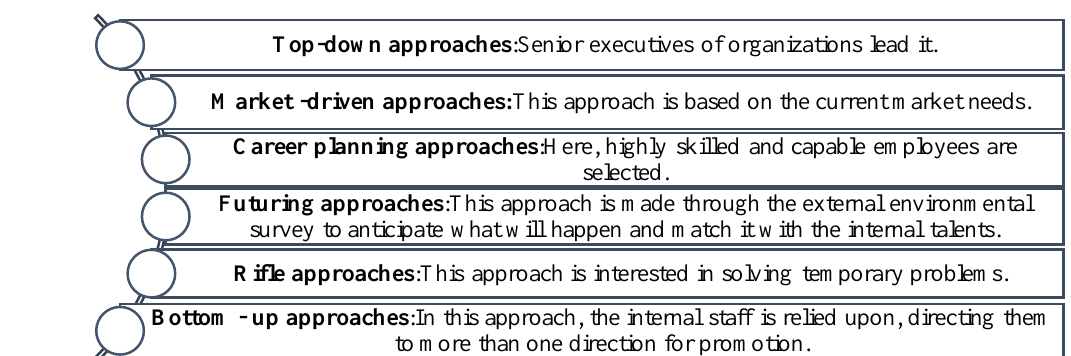
Figure 4. The Six Methods of Succession Planning Strategy